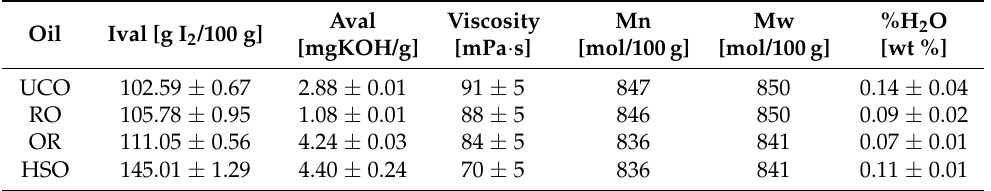
Table 3. Selected properties of the vegetable oils used.